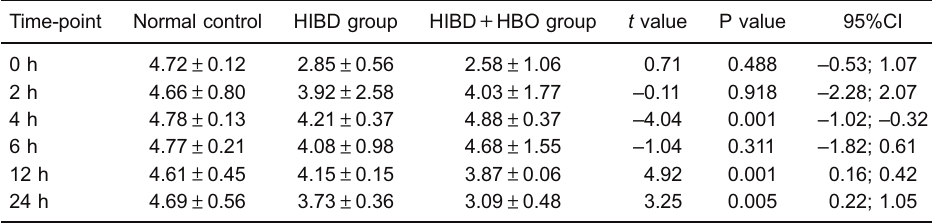
Table 1. Mitochondrial membrane potential (in mean fl uorescence level, MFL) in ipsilateral cortex after a single dose of hyperbaric oxygenation (HBO) during 24 h after hypoxic-ischemic brain damage (HIBD). Time-point Normal control